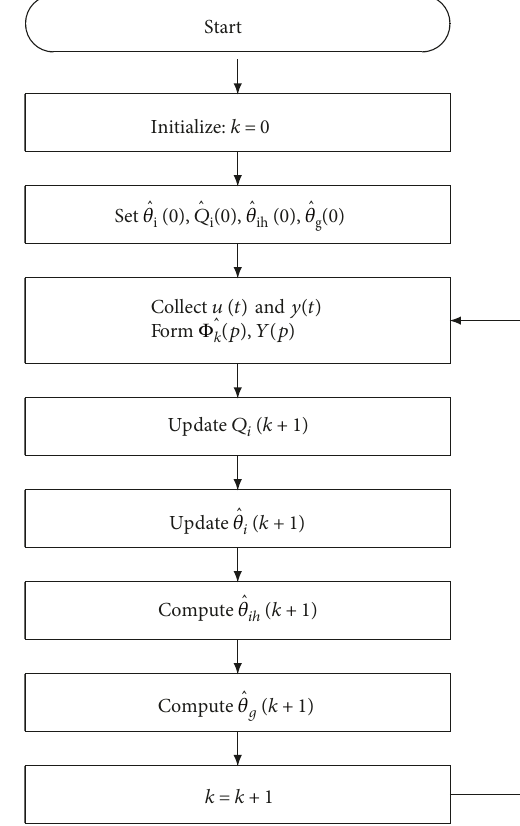
Figure 2: The fl owchart of PSOI